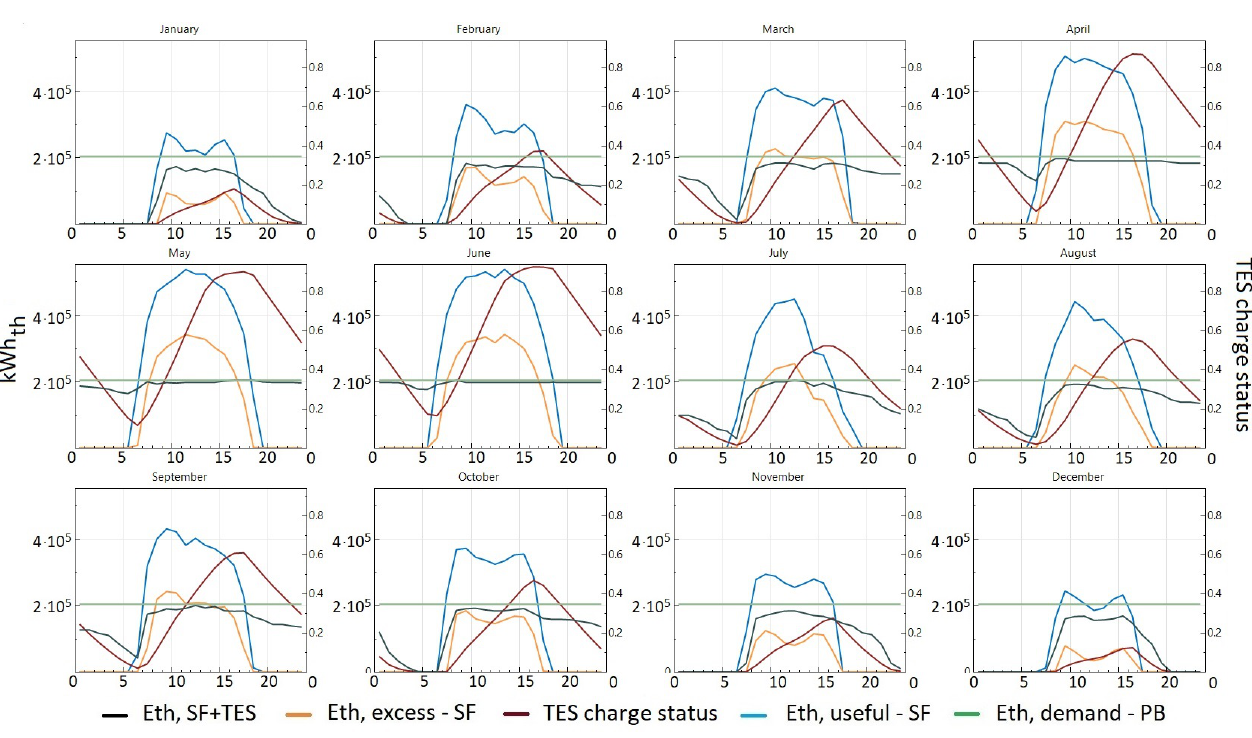
Figure A2. Average monthly time variation of the main energy parameters: Site 2